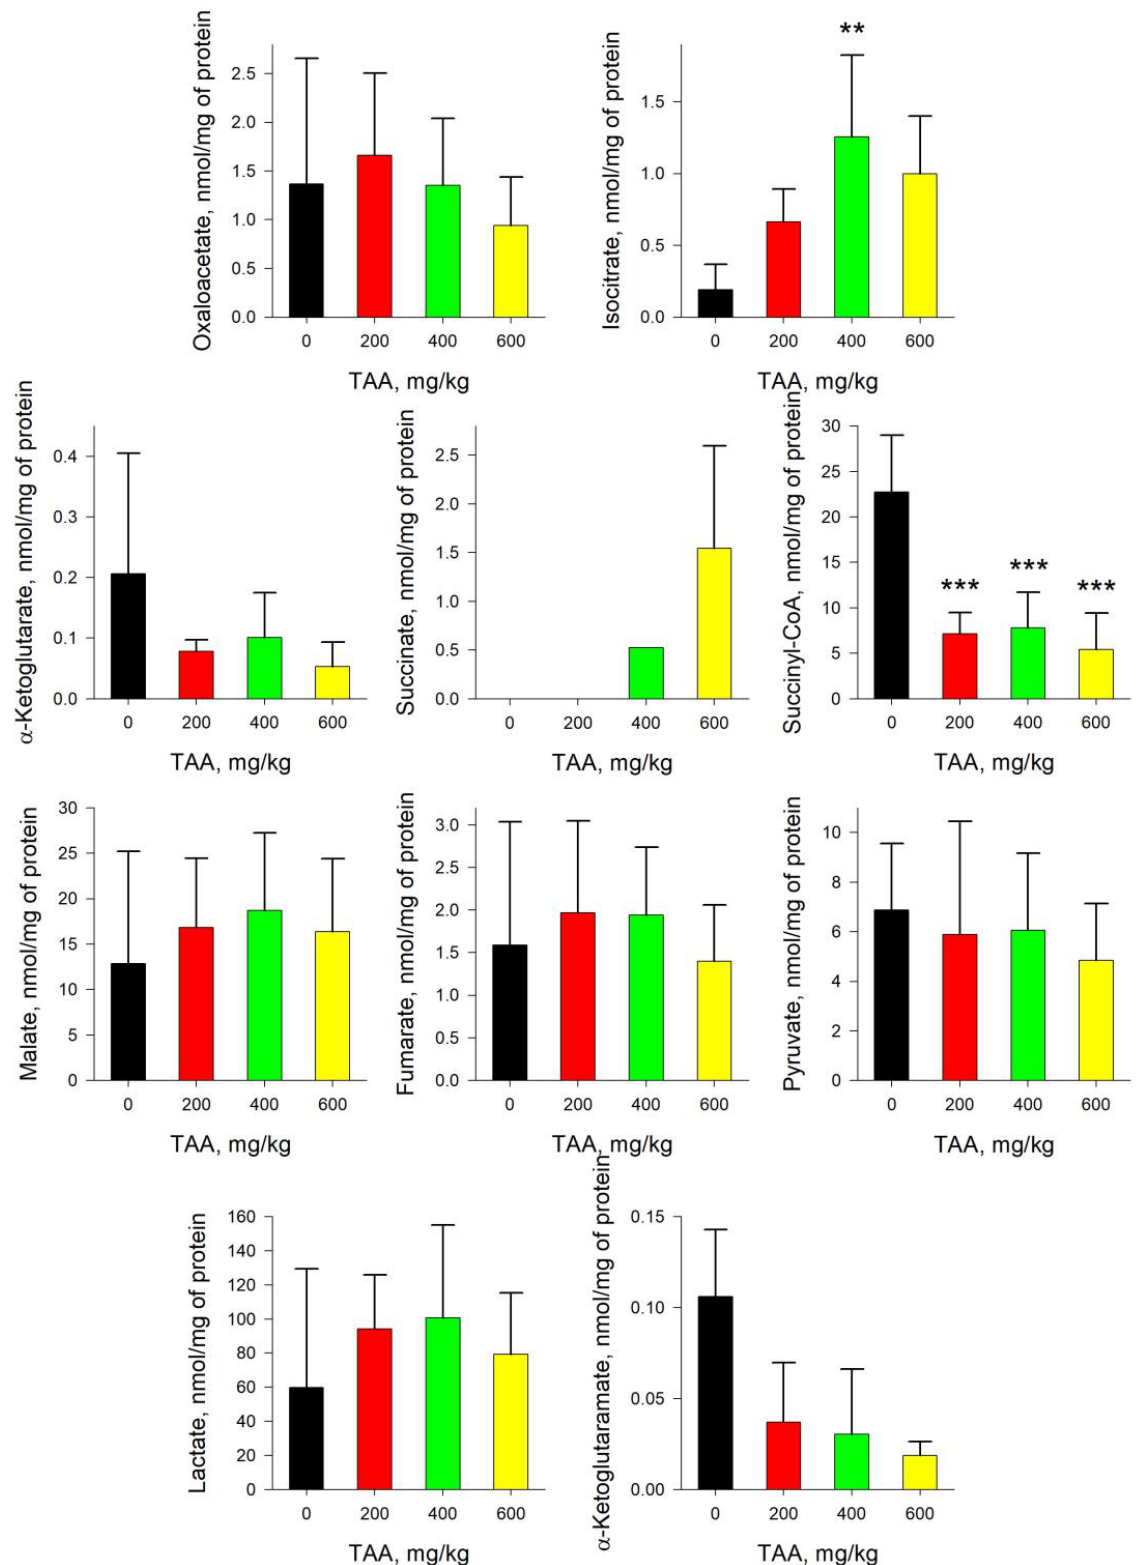
Figure 5. Concentration of TCA cycle and associated metabolites in the kidney tissue of control and TAA-treated rats (AVG ± STDEV, nmol/mg of protein). p -values by Tukey ’s test: ** — p < 0.05; *** — p < 0.005; black stars mean a pairwise comparison to control (for details see Table and Figures in Supplement S1).